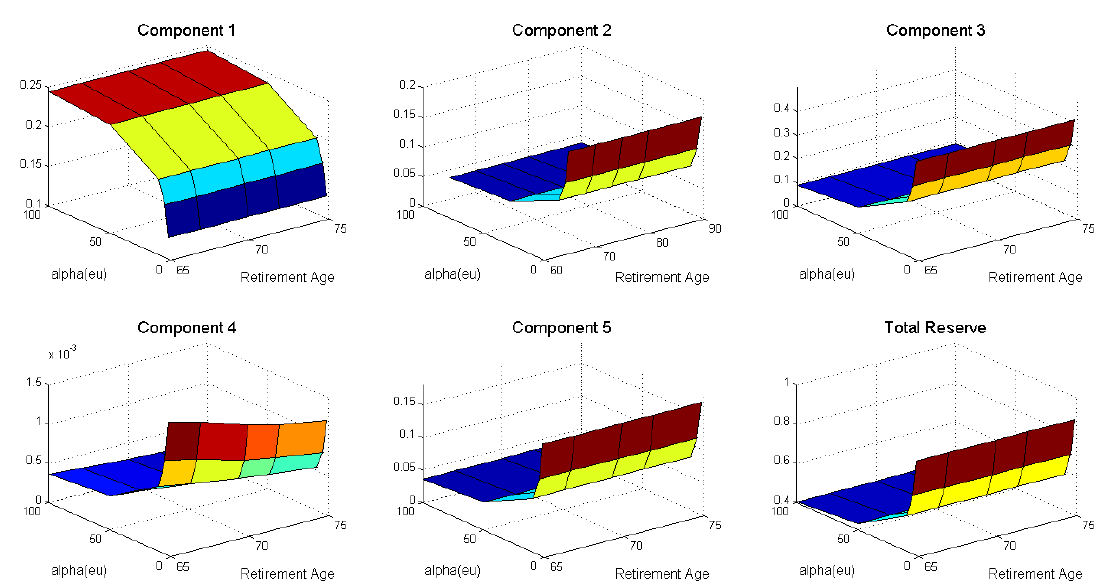
Figure 5. Sensitivity analysis with respect to α ( eu ) by components and total